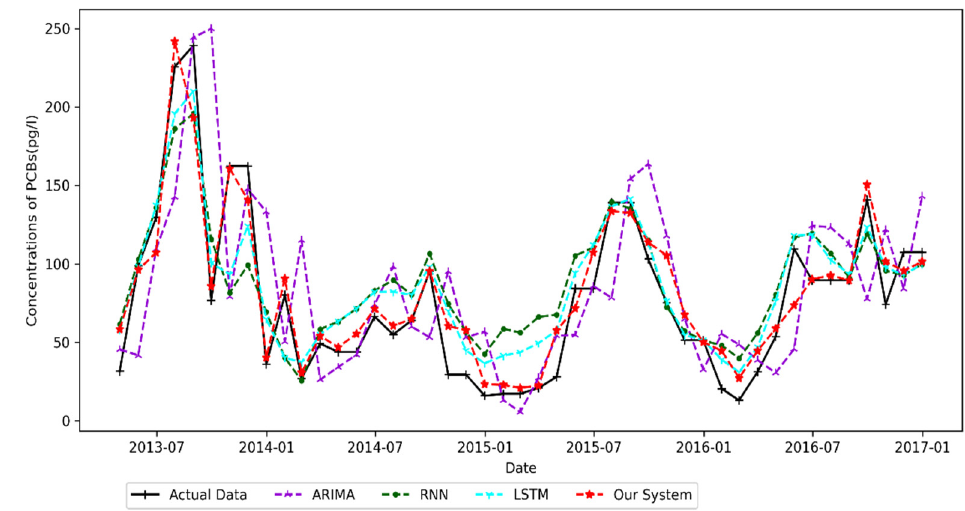
Figure 9. Prediction results of each model on Point Petre dataset.